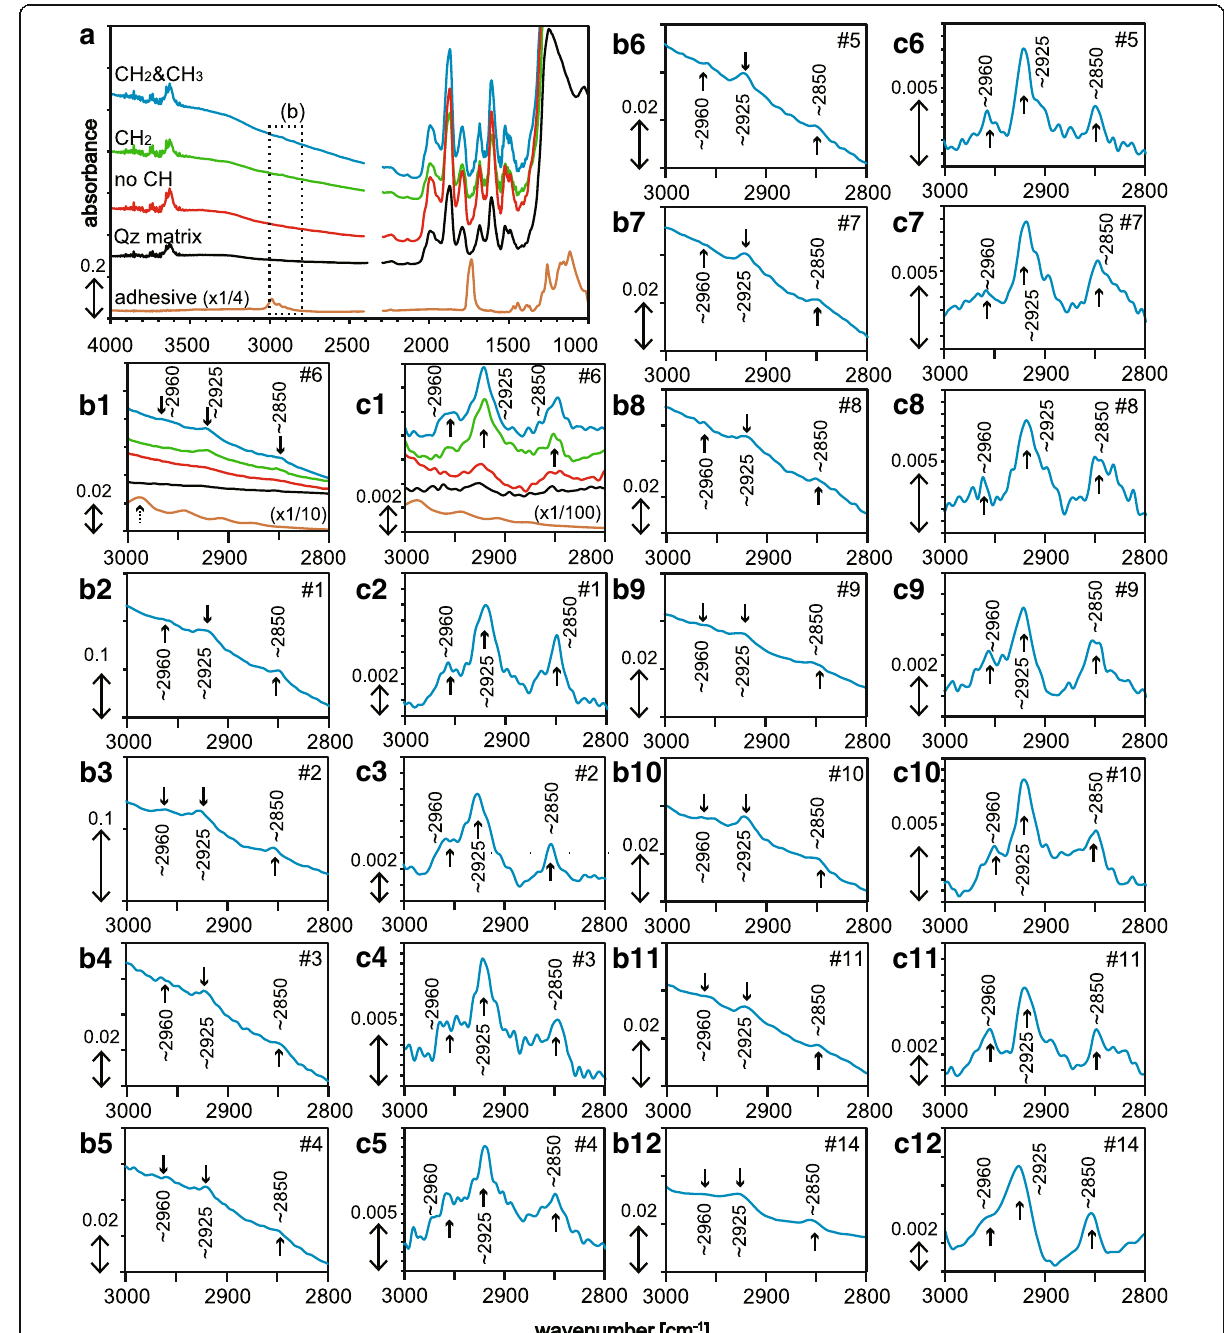
Fig. 4 The transmission IR absorbance spectra (1024 scans) of the carbonaceous clots. a Examples of the IR spectra of the carbonaceous clots with aliphatic CH 2 and CH 3 bonds (blue line: spot #6 in Table 1), only aliphatic CH 2 bond (green line: spot #12 in Table 1), and no CH 2 bond (red line: spot #13 in Table 1) together with quartz matrix (black line). IR transmission-reflection spectrum of the carbon-based dissolvable adhesive used in this study on an aluminum foil is shown by the brown line (modified from Igisu et al. 2006). One scale unit on the vertical axis corresponds to an absorbance of 0.2. (b) An enlarged view of the IR spectra within 3000 – 2800cm − 1 . The range for b1 is indicated by the dotted rectangle in a . Spot numbers (#1, #2, etc.) are shown in the upper right in each figure. One scale unit on the vertical axis corresponds to an absorbance of 0.02 in b1 and b4 – b12 , and 0.1 in b2 and b3 . c The IR spectra after linear baseline correction of the spectra in b within 3000 – 2800cm − 1 . Spot numbers (#1, #2, etc.) are shown in the upper right in each figure. One scale unit on the vertical axis corresponds to an absorbance of 0.002 in c1 and c12 , and 0.001 in c2 – c11 . The spectra of the adhesive are re-scaled to a quarter in a , one-tenth in b1 , and one-hundredth in c1 for